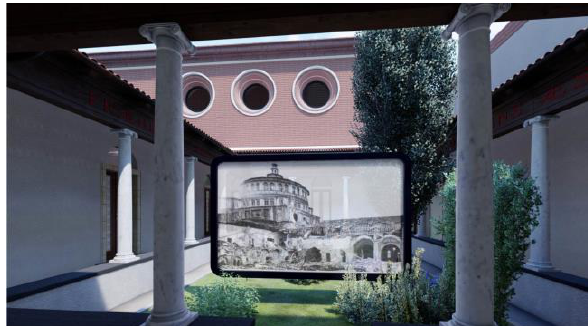
Figure 11. View of the virtual environment. In the centre of the cloister, a video showing the consequences of the bombing of